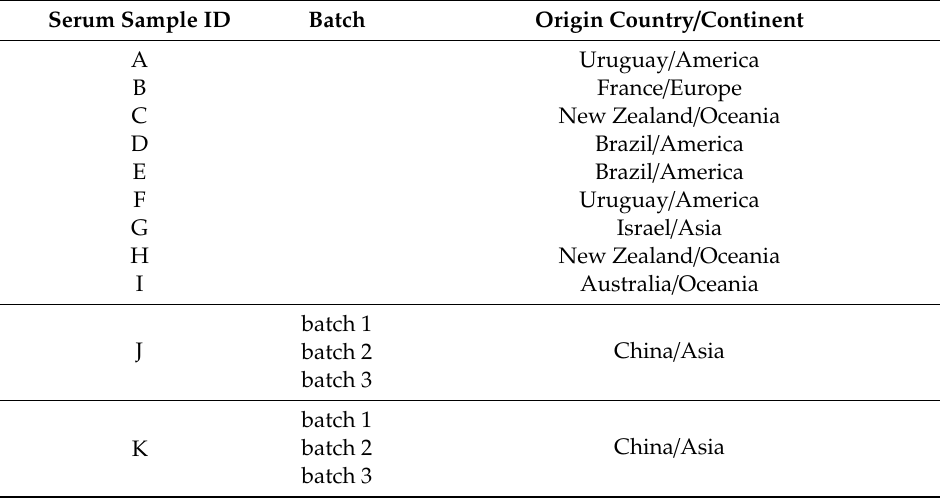
Table 1. The information on each bovine serum sample tested in the present